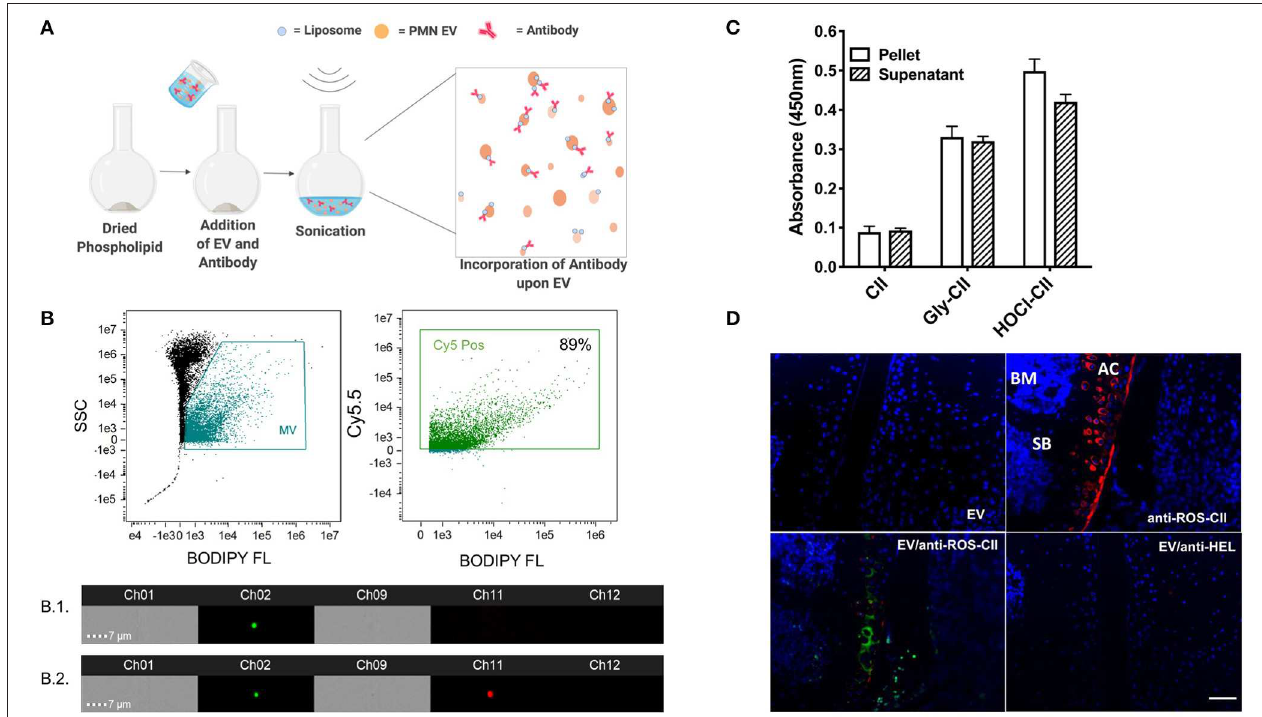
FIGURE 1 | EV/anti-ROS-CII in vitro characterization. (A) Anti-ROS-CII antibodies were loaded onto PMN-derived EV (EV/anti-ROS-CII) through a process of energy dissemination and fusion with lipid vesicles, as outlined in the schematic created with BioRender. (B) Incorporation of anti-ROS-CII antibodies upon EV was assessed by ImageStream X . Representative image of EV (B.1) and EV enriched with anti-ROS-CII antibody (B.2) obtained from the ImageStream analysis, with bright field shown in channels 1 and 9, Ch01, and Ch09; side scatter in channel 12, Ch12; EV fluorescence (BODIPY) in channel 2, Ch02; and antibody fluorescence (Cy5.5) in channel 11, Ch11. Of the EV population, 89% was positive for the anti-ROS-CII fluorescence. (C) Antibody functionality after incorporation upon EV was tested by ELISA. Binding characteristics to native collagen type II (CII) and ROS modified CII (CII modified by ribose; Gly-CII and HOCl; HOCl-CII) were determined. Both pellet and removed supernatant were analyzed to determine the relative antibody reactivity loaded upon EV, as compared to the unbound. Data are shown as mean ± SEM, n = 3. There was a significant difference between reactivity to native CII vs. ROS-CII (Gly-CII and HOCl-CII, p < 0.001), but no main effect between pellet and supernatant ( p > 0.05). (D) Binding specificity was also determined using sections from mouse antigen-induced arthritis knee tissue taken 7 days after induction. Immunofluorescence of EV (BODIPY FL) and EV enriched with either anti-ROS-CII (EV/anti-ROS-CII, Cy5.5) or control antibody specific to hen egg lysozyme (EV/anti-HEL) binding within the arthritic cartilage was assessed. Specific binding to articular cartilage (AC) was observed by anti-ROS-CII and EV/anti-ROS-CII but not with EV or EV/anti-HEL. SB, subchondral bone; BM, bone marrow. Scale bar = 50 µ